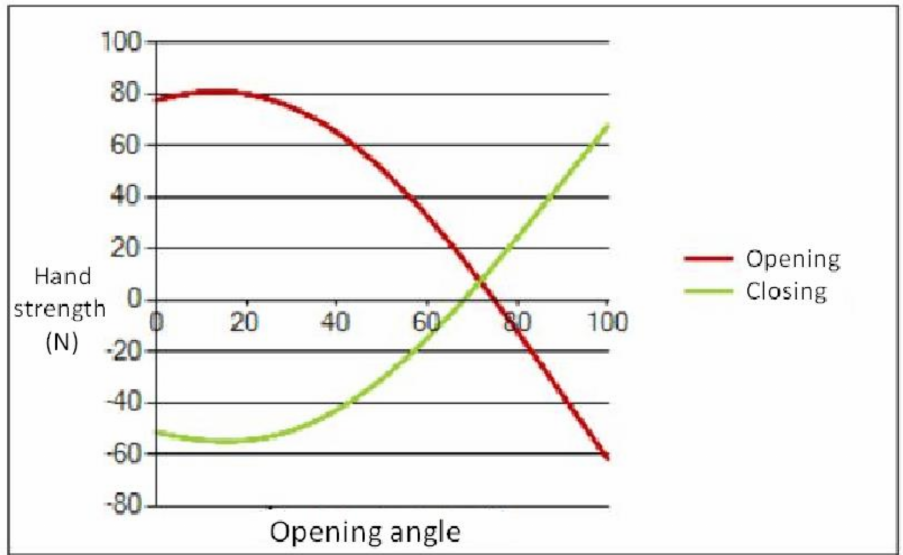
Figure 4. Lifting force of pneumatic struts calculated for the hatch.